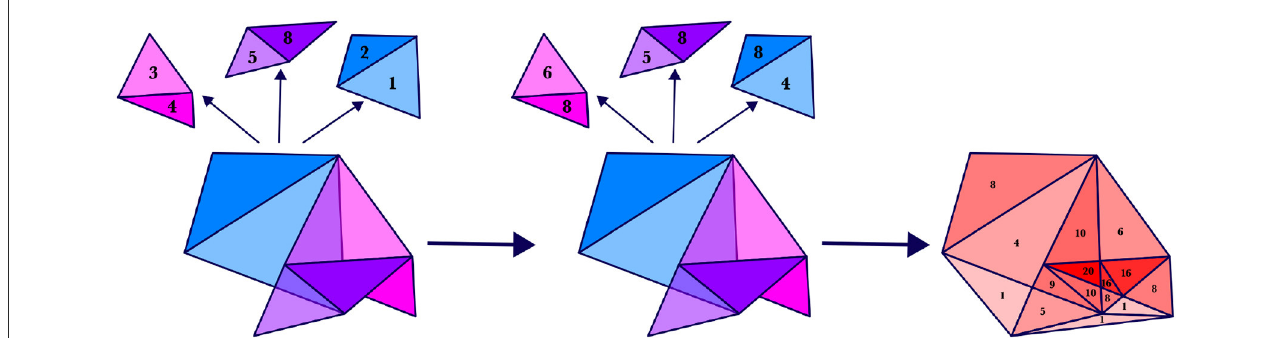
FIGURE9 (Left) Regions corresponding to three motor silhouettes at a particular time; each silhouette at this time has a two subregions, with weights labeled. (Center) The regions with scaled weights. (Right) The weighted combination of the regions.